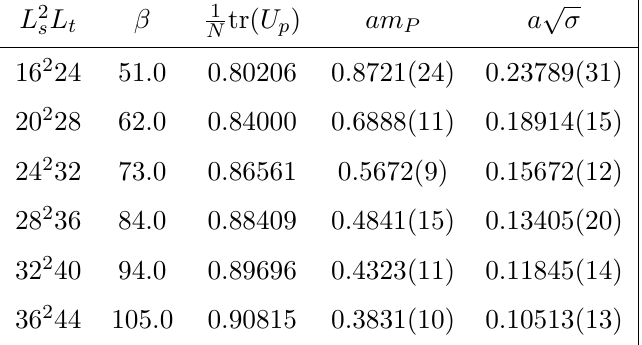
Table 16 . SO(8) average plaquette values, (cid:13)ux loop masses, and string tensions.